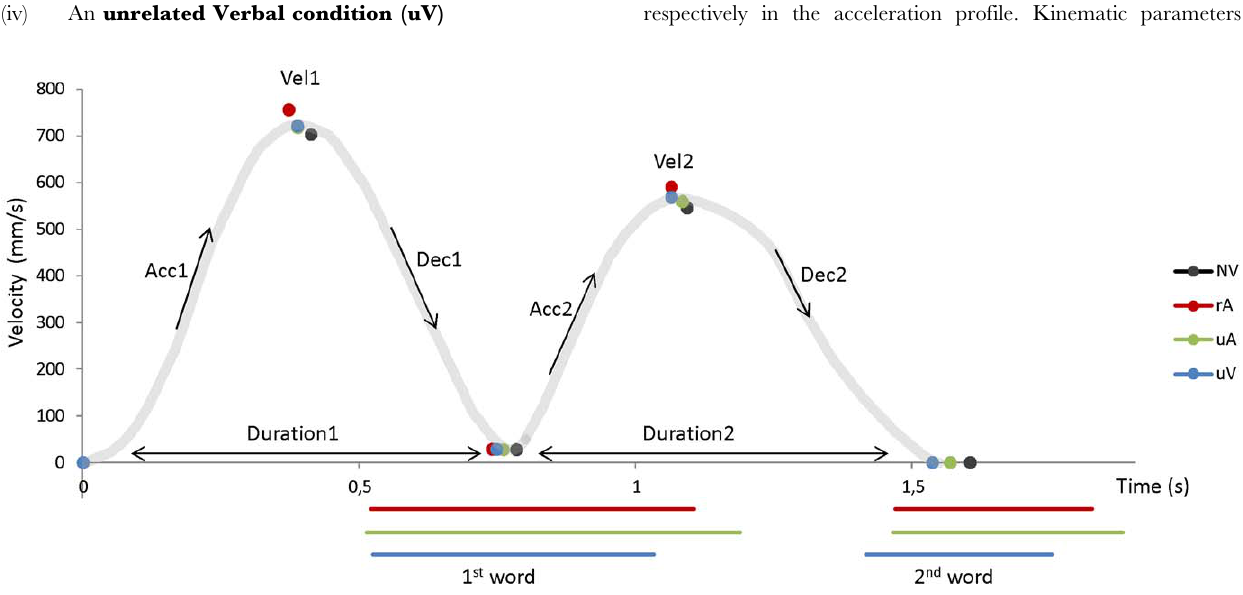
Figure 2. Kinematic profile of the movement. The gray curve represents a theoretical velocity curve of the movement. Acceleration peaks, Velocity peaks, Deceleration peaks and movement durations were measured. The reported dots correspond to the data obtained in Experiment II for each condition. Word durations are depicted as lines and onsets of word-production are locked to the movement (Red, green and blue lines represent rA, uA and uV conditions respectively).